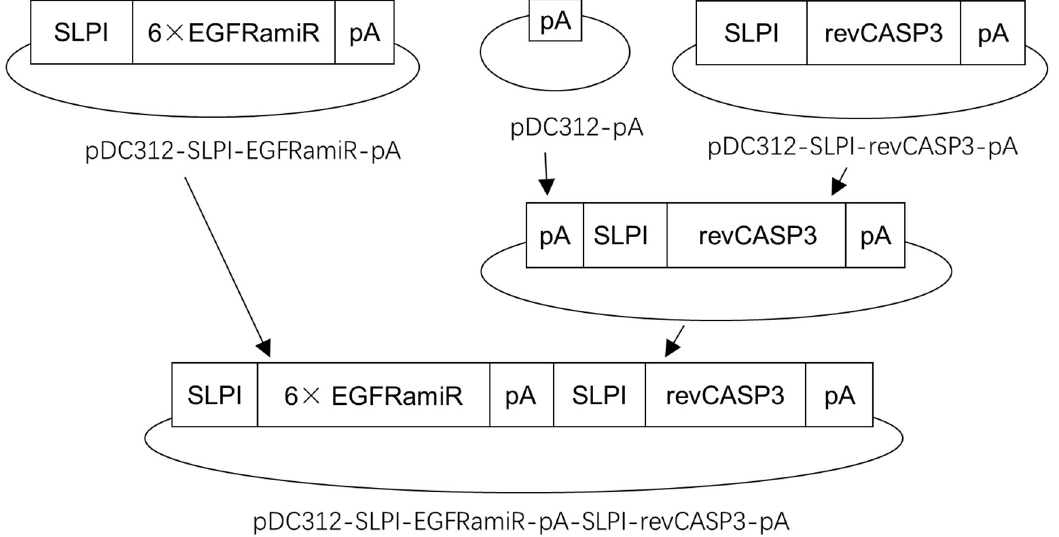
Fig 1. Strategy for pDC312-SLPI-EGFRamiR-pA-SLPI-revCASP3-TAG-pA